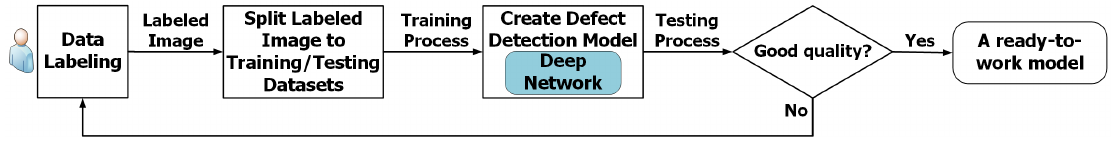
Figure 2. A standard model generation flowchart in solutions of the deep learning-based methodology.